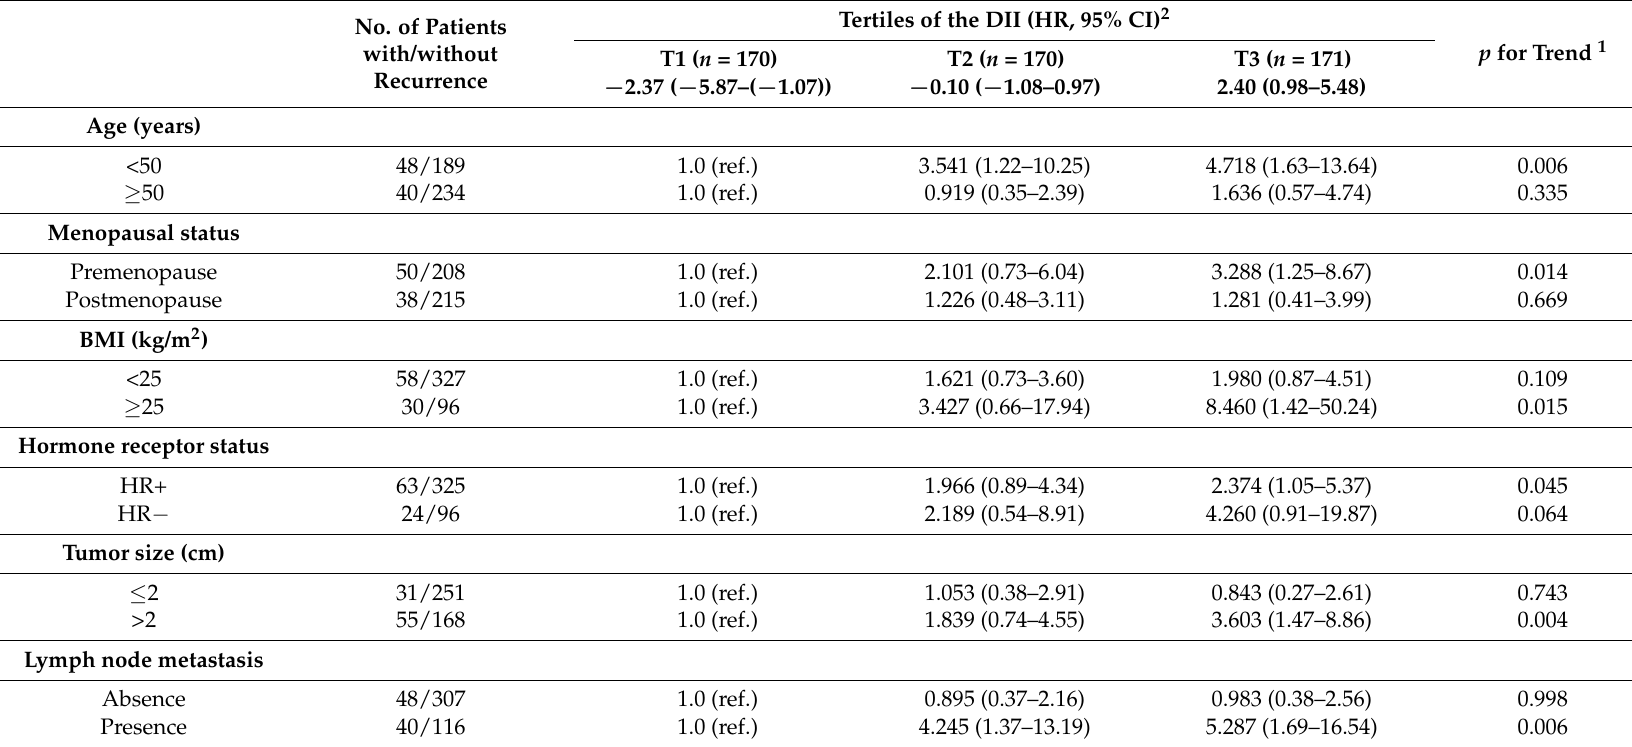
Table 3. Cox proportional hazards regression analysis of prognostic factors affecting recurrence in patients with breast cancer according to dietary inflammatory index